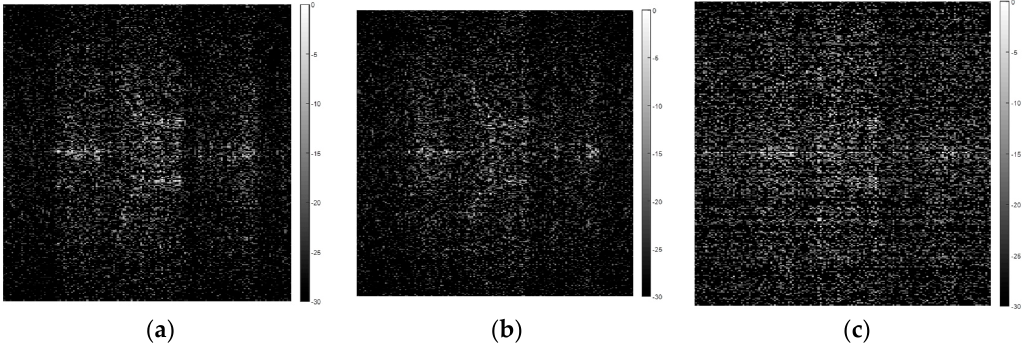
Figure 13. Effects of WBNI suppression for range-azimuth imaging based on the DDSE algorithm under different compression ratios. ( a ) CR = 1/2; ( b ) CR = 1/4; and ( c ) CR = 1/8.